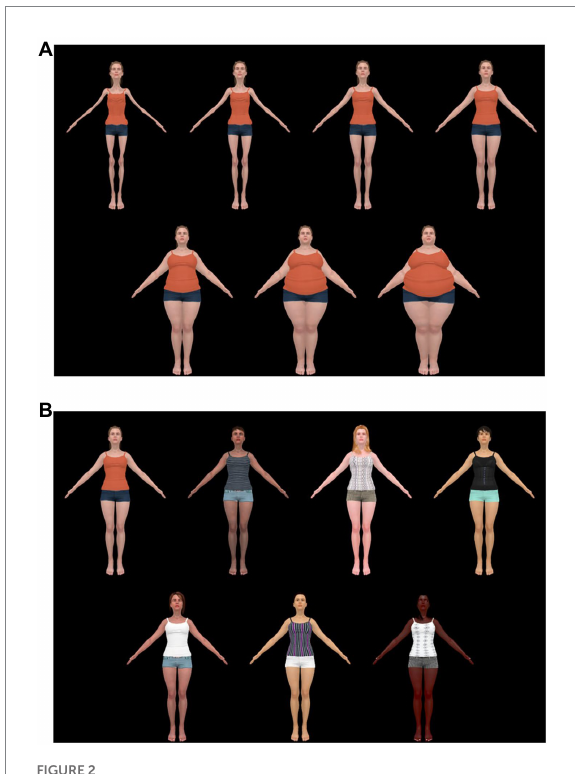
FIGURE 2 (A) Examples of the seven body stimuli from body Size 1 (very underweight) to 7 (very overweight). On the top row, from left to right, are bodies Size 1, Size 2, Size 3, and Size 4. On the bottom row, from left to right, are bodies Size 5, Size 6, and Size 7. (B) Examples of the seven body identities. The original source of these images can be found at Turnbull et al. (2022). The stimuli was created using ©Character Creator and using Shape Keys (e.g., an animation industry technique which smoothly interpolates between the vertices of the two models) to create the intermediate body types by linearly interpolating between the Size 1 and Size 4 bodies. Both figures are reproduced from Turnbull et al. (2022), with permission from SAGE Publications.